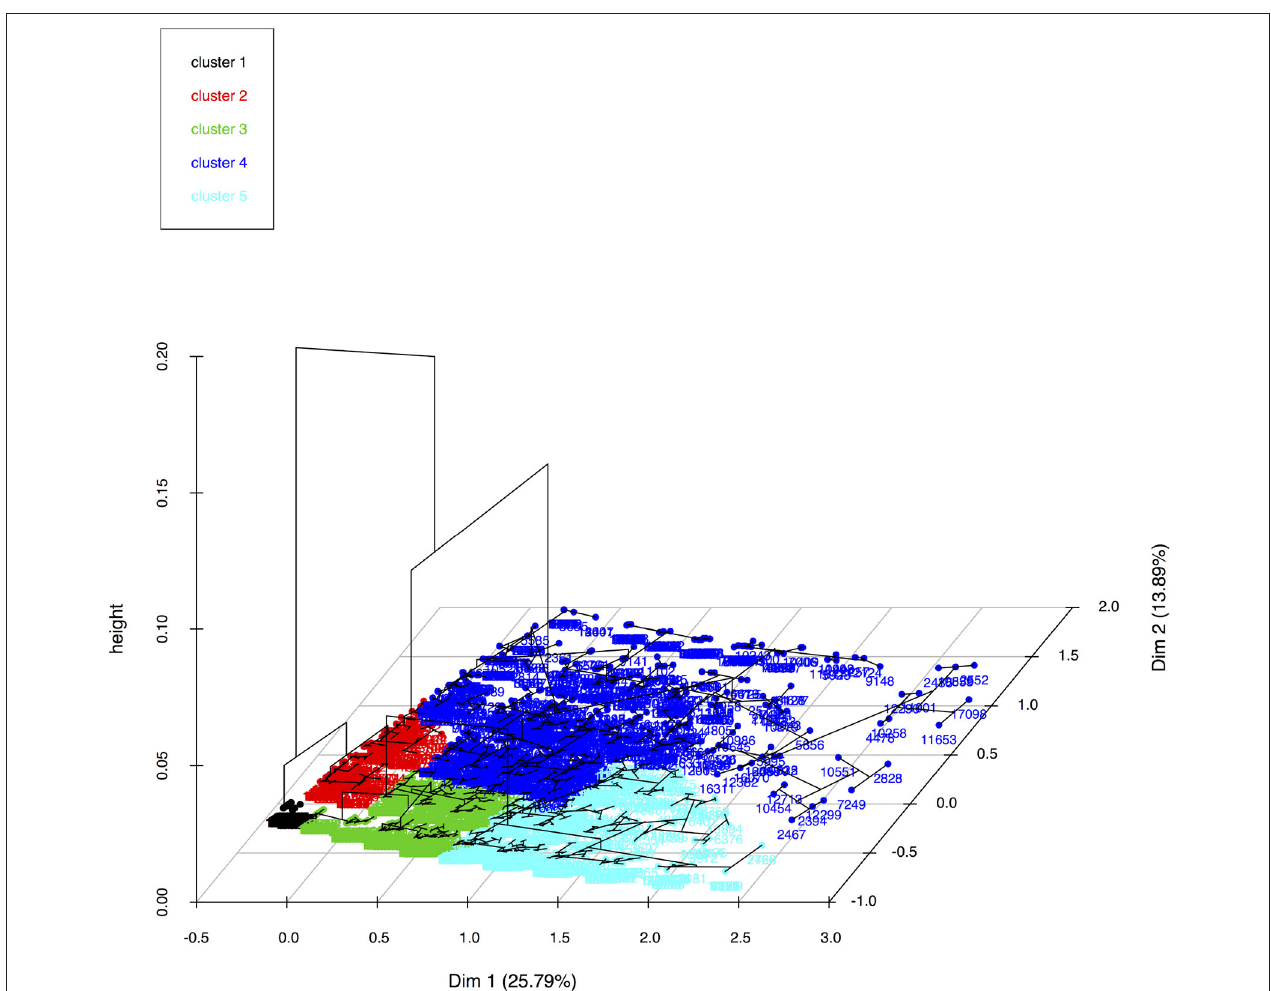
FIGURE 7 | Agglomerative hierarchical clustering solution obtained by applying Ward’s method and by using the Euclidean distance ( n = 19,050 individuals). Each dot represents an individual’s response pattern and the numerical id of each individual is included in the plot. Note that dots may overlap when one or more individuals have the same response pattern. Clustering variables: object scores of the MCA dimensions 1 and